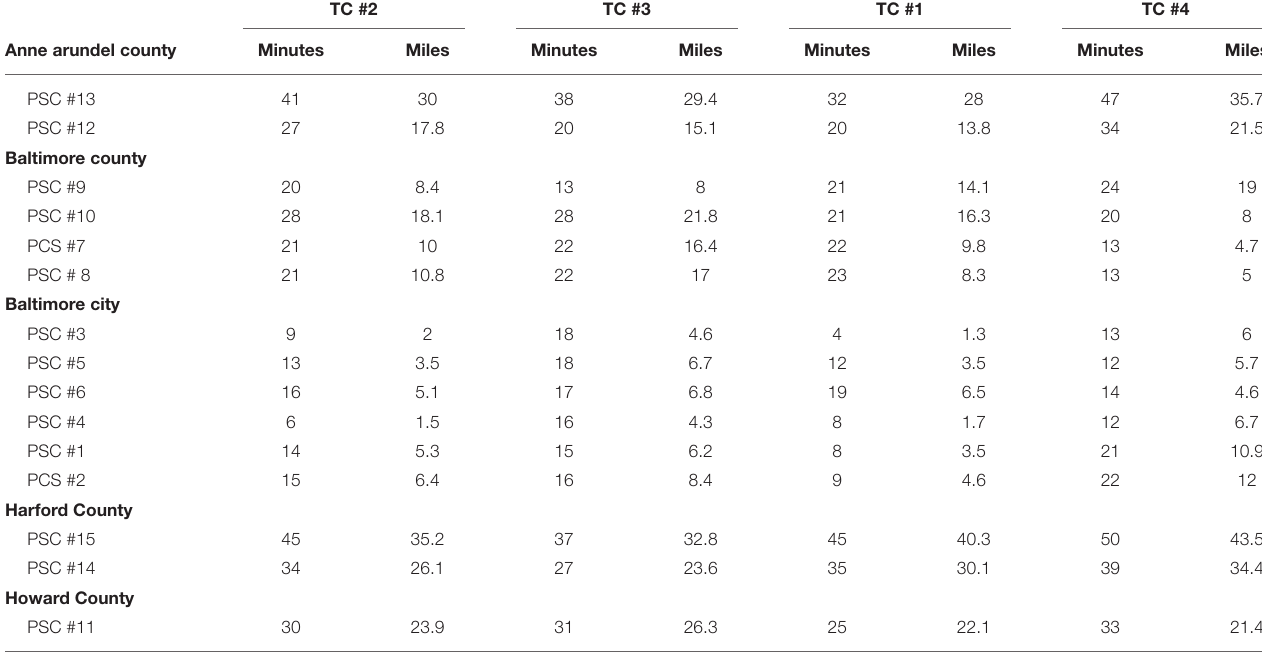
TABLE 1 | Drive time from PSC to Thrombectomy Centers